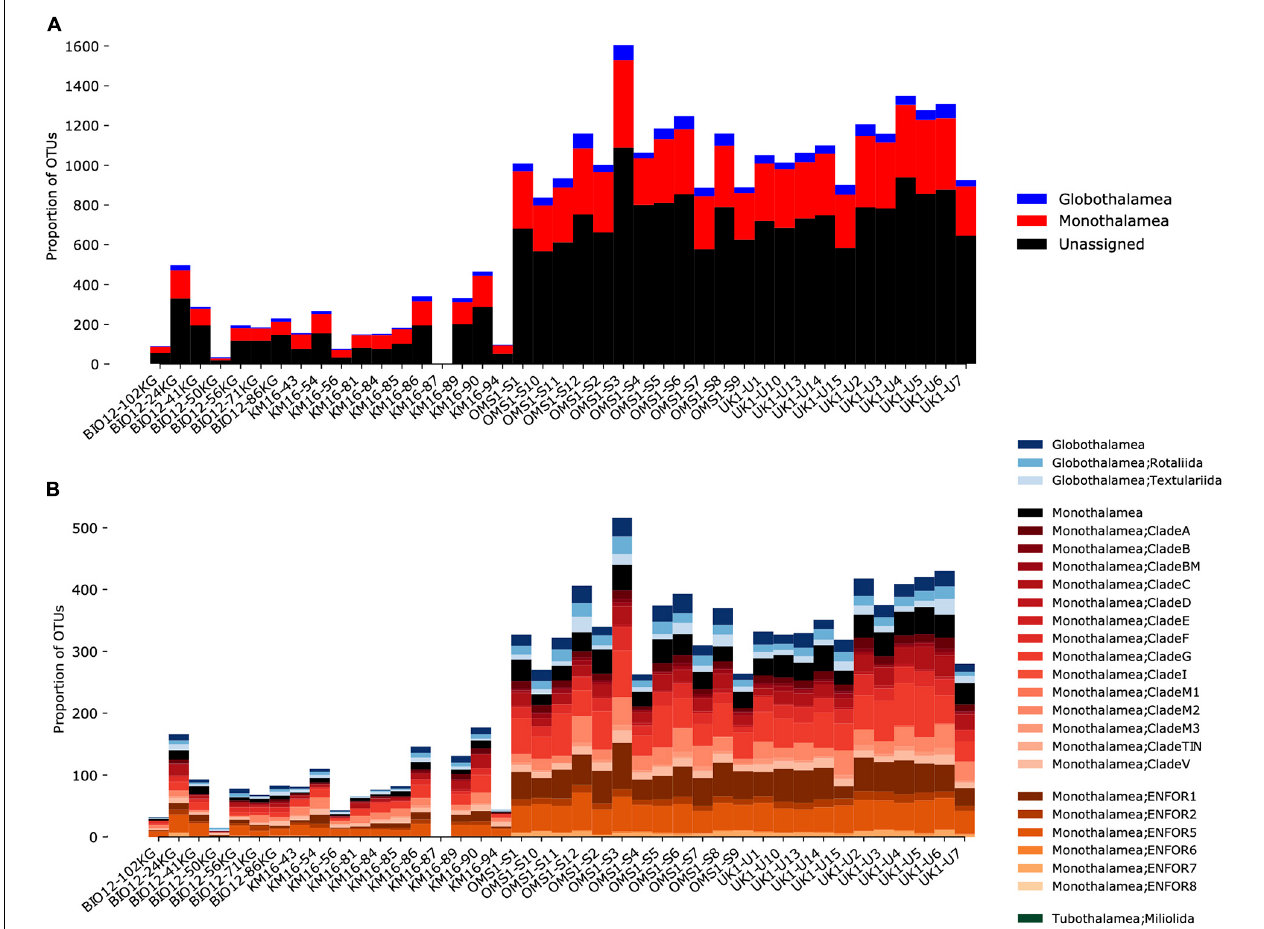
FIGURE 5 | Taxonomic composition of the OTUs found in samples from CCZ sites. The top panel includes the unassigned OTUs (A) , which are absent in the bottom panel where only OTUs that were assigned to Globothalamea, Tubulothalamea, and Monothalamea are shown, at a finer taxonomic level (B) ; note the high diversity of monothalamid